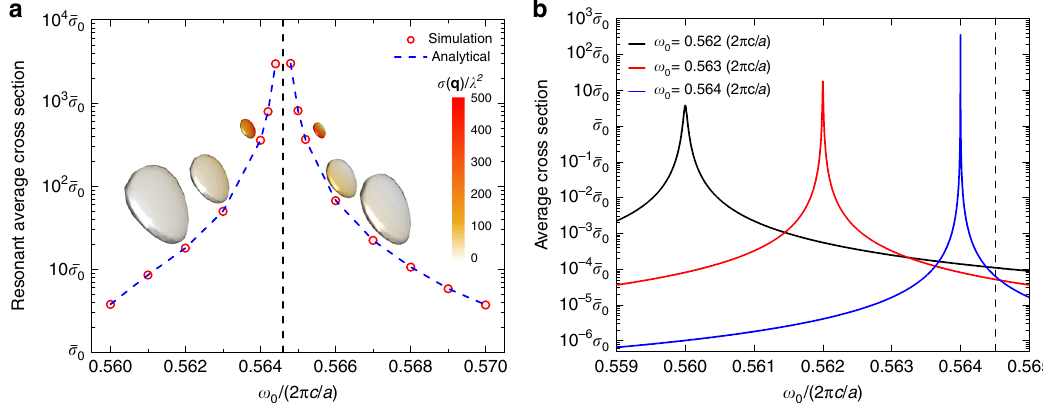
Fig. 4 Resonant scattering cross section in Weyl photonic crystal. a Diverging resonant scattering cross section is realized around the Weyl frequency. Isosurfaces have an ellipsoidal shape (insets) with its colour indicating the value of the cross section; the shrinking isosurface leads to increasing cross sections around the Weyl frequency, which is indicated by the black dashed line. The results from quantum scattering simulation (red circles) agree well with the prediction based on the band structure (blue dashed line). The cross section is normalized by the average cross section in free space σ 0 ¼ λ 2 = π . It scales as σ (cid:2) 1 = Δ ω 2 . b Spectra of average scattering cross sections for TLSs with different transition frequencies. For simplicity, the spontaneous emission rates of the TLSs in vacuum are chosen to be 10 (cid:3) 4 ω 0 . We also assume the dipole moments and locations of the TLSs are the same. The black dashed line also indicates the Weyl frequency